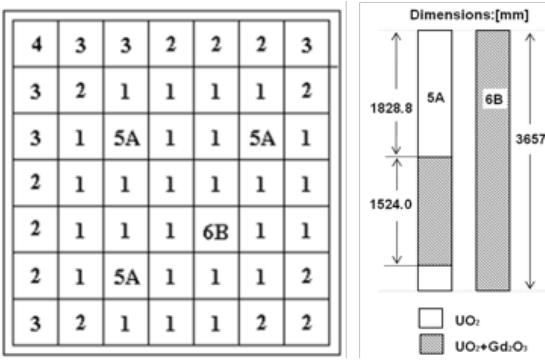
Figure 5. The PB-2 assembly benchmark model